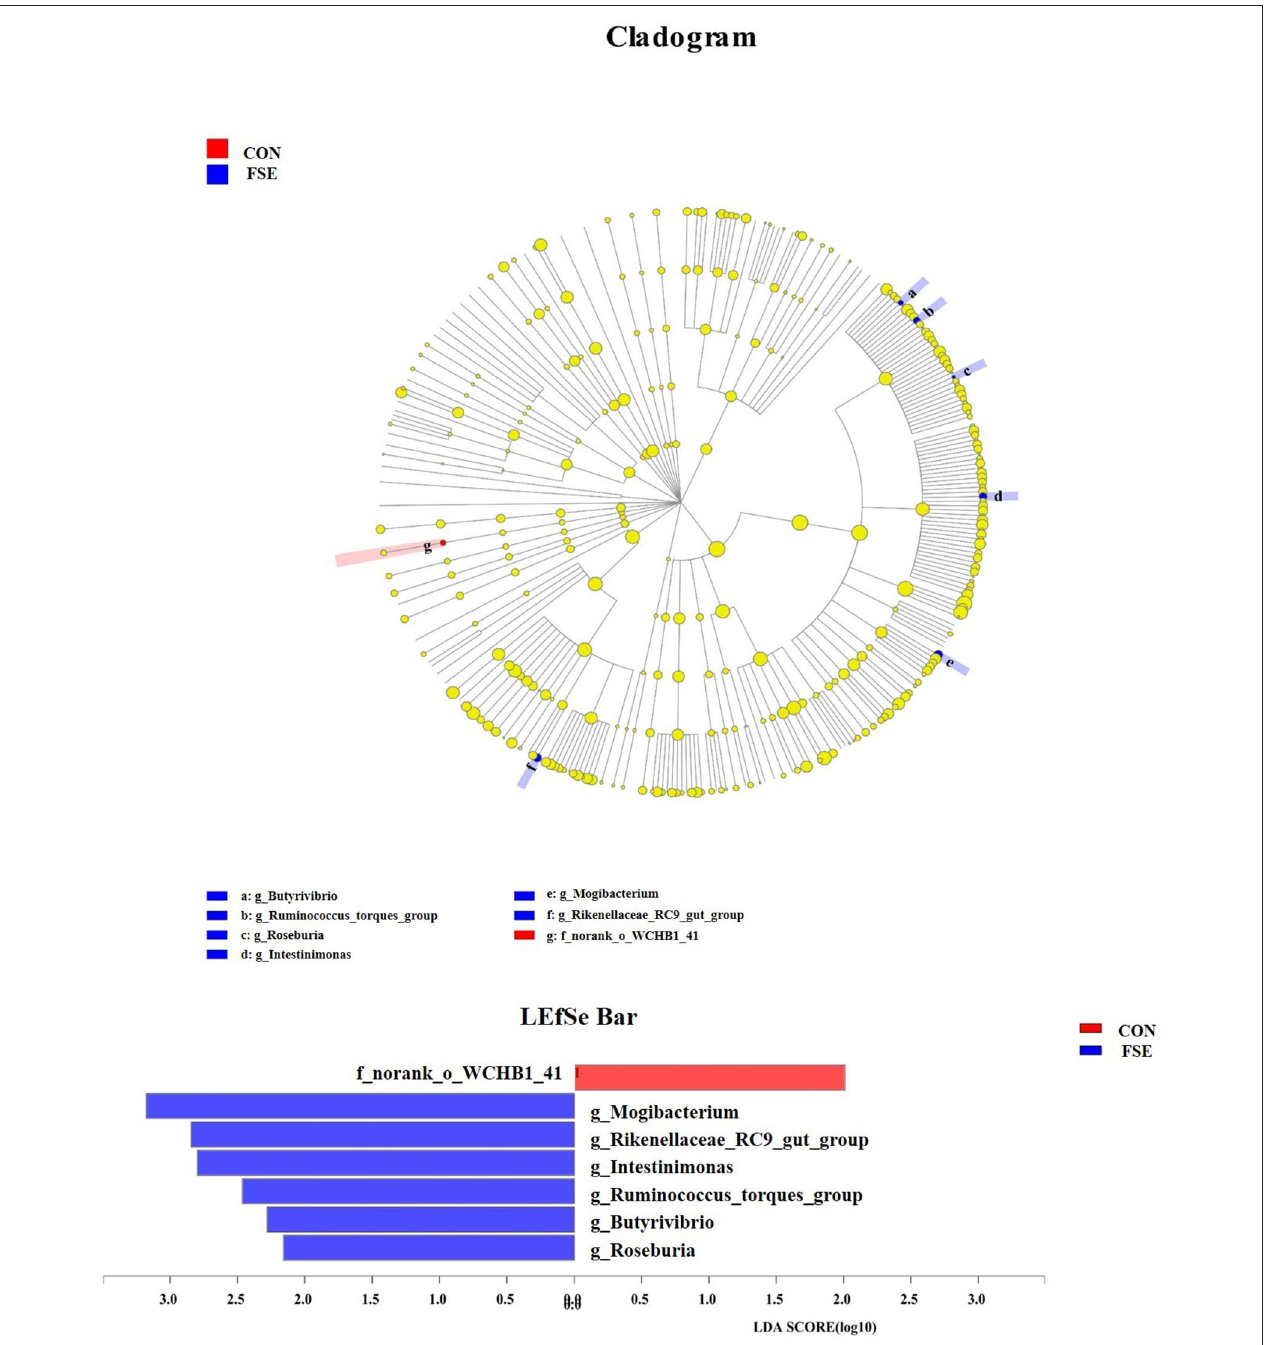
FIGURE 9 | The analysis for different bacteria communities from phylum to genus level in the cladogram of LEfSe among treatments. Relative abundance of bacteria communities from phylum to genus level in feces of sows. CON, control; FSE, Forsythia suspensa extract. n = 4. that maternal FSE supplementation could increase the